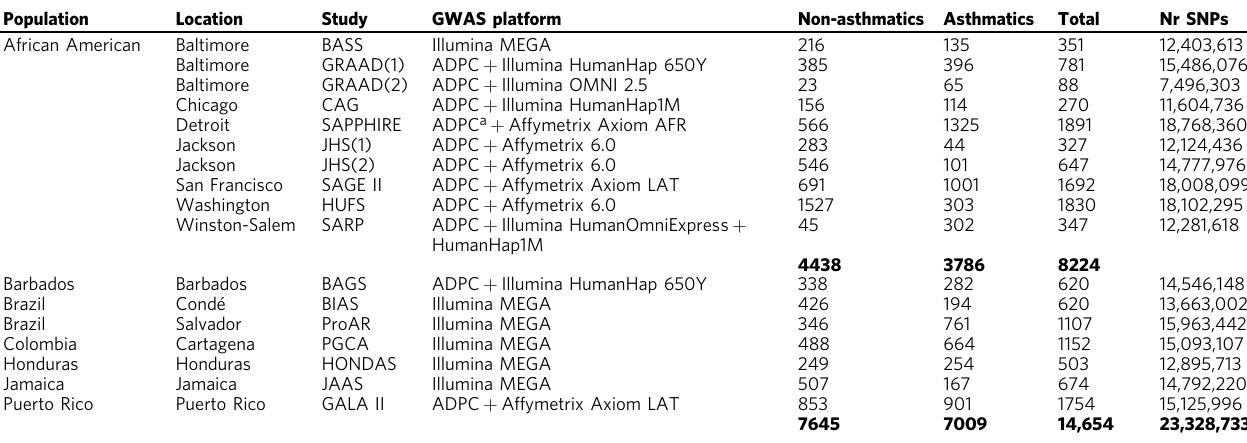
The table summarizes the geographical location and fi nal number of subjects and imputed SNPs included in the asthma association analysis. Bold numbers are the sum of the numbers above. a ADPC data available for 730 asthmatics